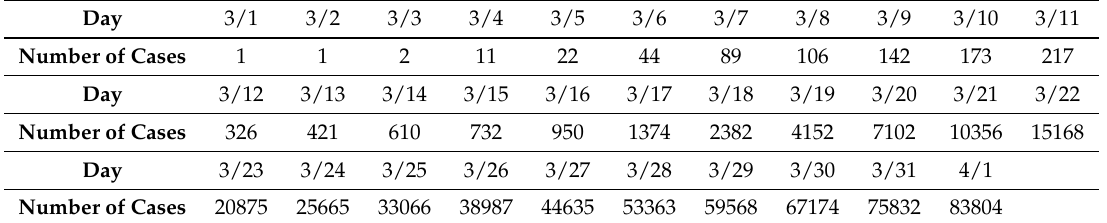
Table 1. Total number of cases reported in NY state from 1 March to 1 April. See [20].